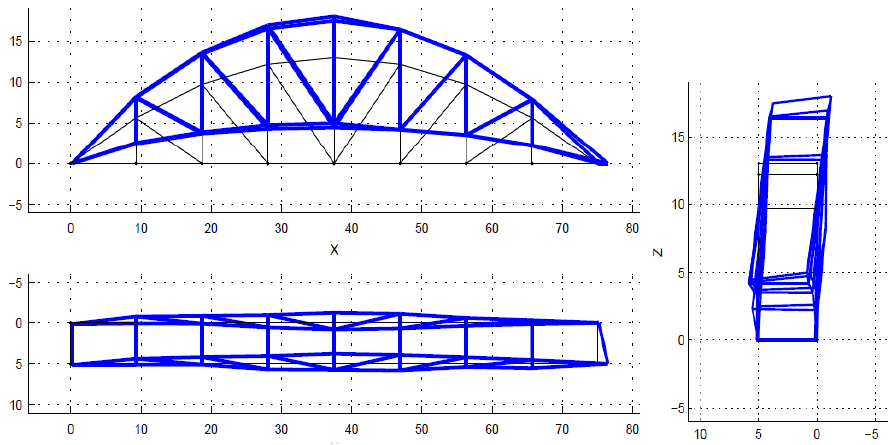
Figure 10. The identified mode 4, first vertical bending, f = 4.62 Hz, xi = 2.54%.